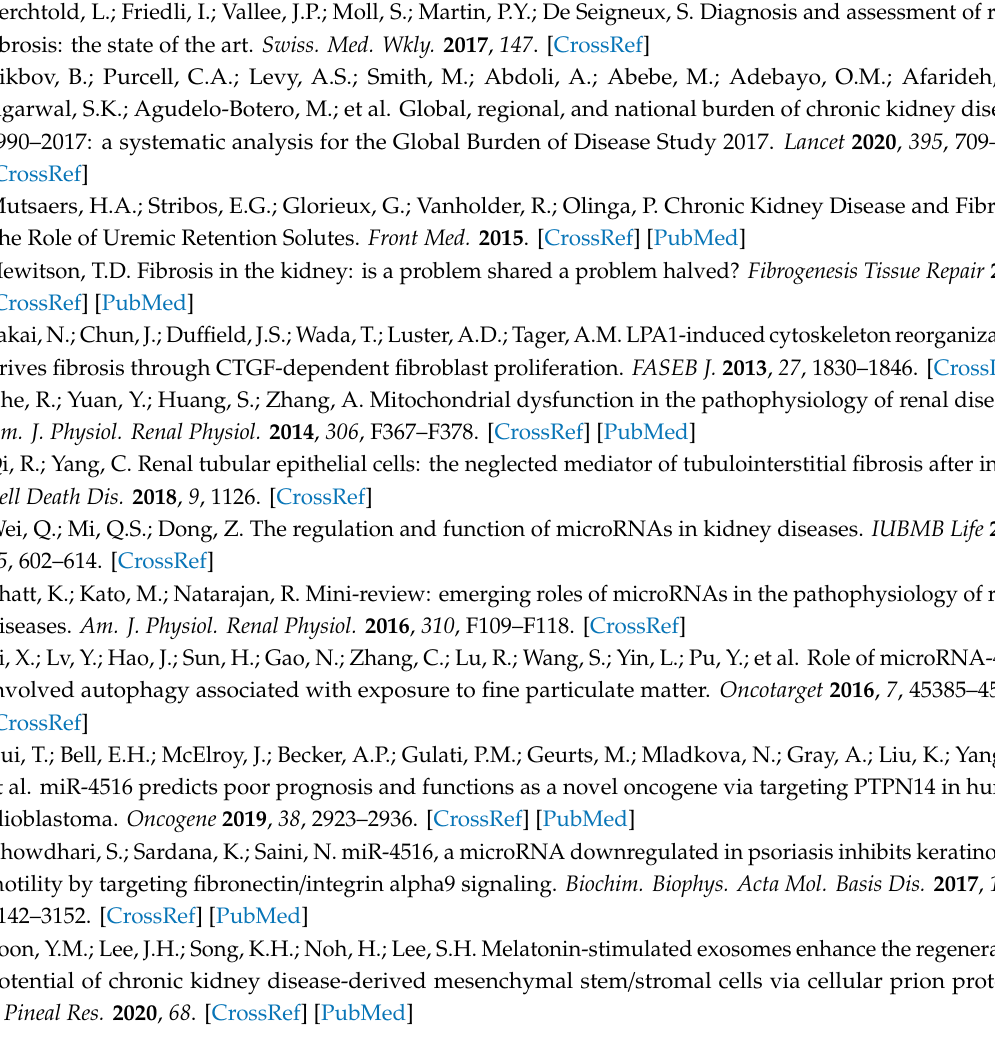
Figure S1. E ff ect of melatonin on cell cycle and apoptosis of P -cresol-treated TH1 cells. Figure S2. Melatonin inhibitor luzindole blocks the e ff ects of melatonin on mitochondrial function. Figure S3. E ff ect of melatonin on cell cycle and apoptosis of P -cresol-treated TH1